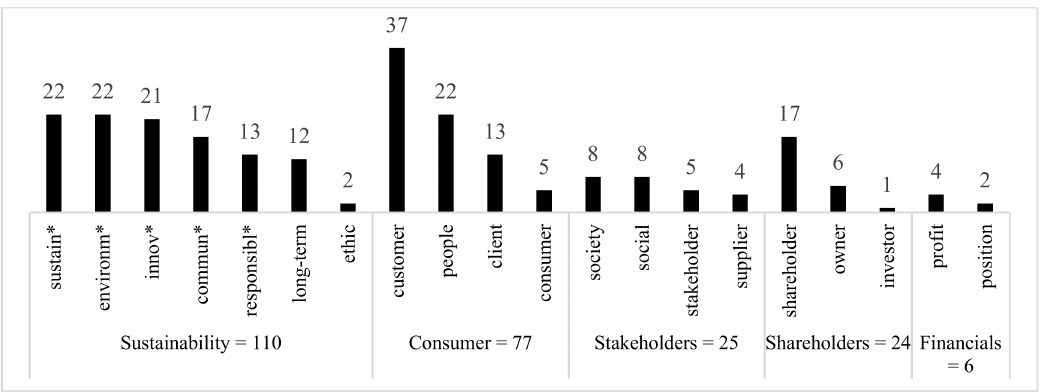
Figure 2. Results of the mission statement analysis of CEE companies—created by